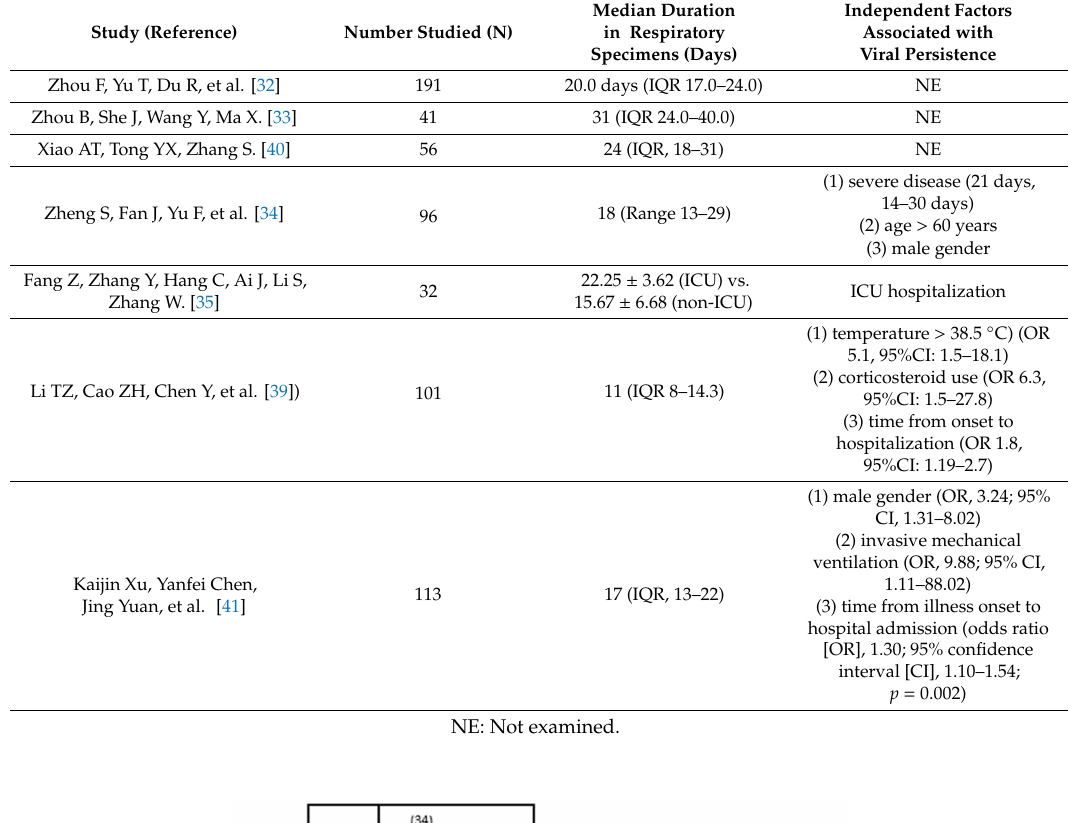
Table 1. Factors associated with viral persistence in the clinical specimens from COVID-19 patients.